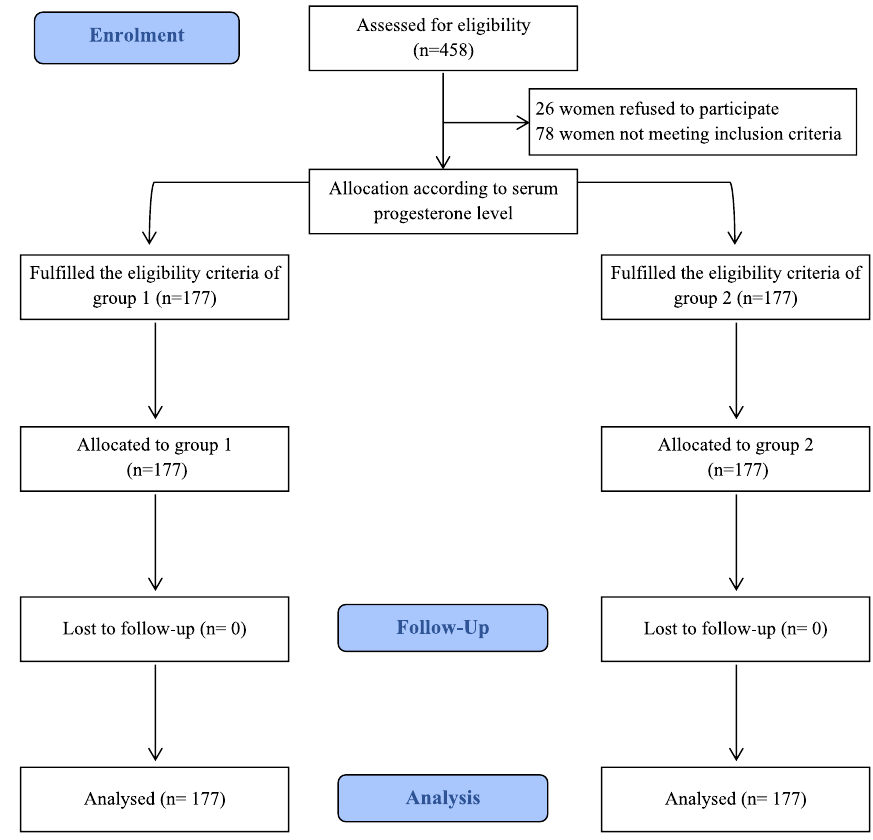
Fig. 1 Study enrolment and